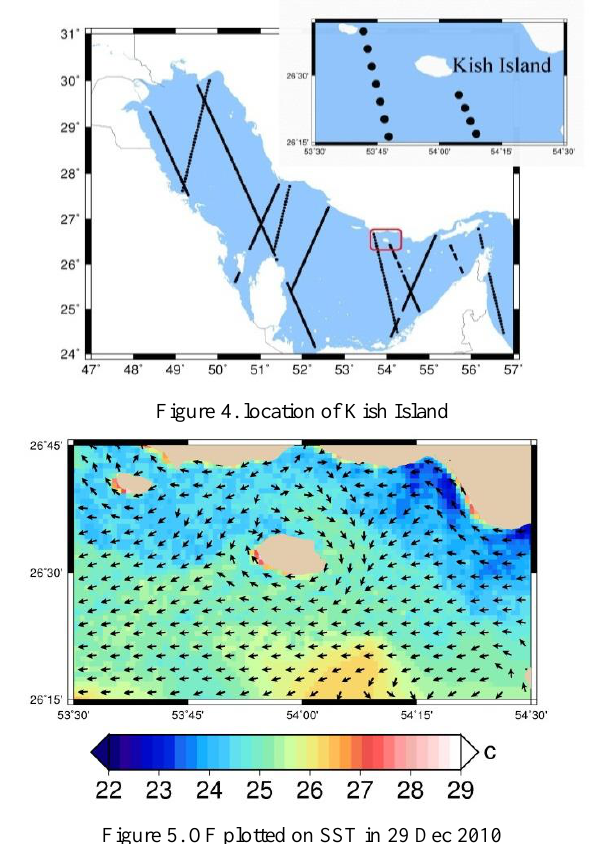
Figure 5. OF plotted on SST in 29 Dec 2010